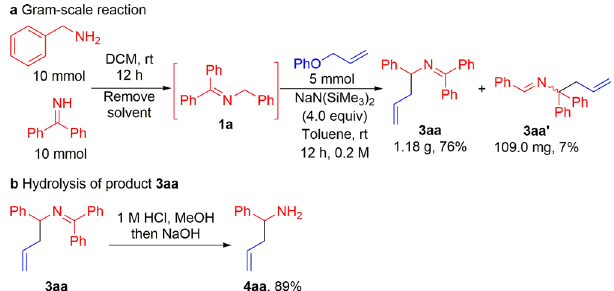
Fig. 5 Synthetic applications. a Gram-scale sequential one-pot imine generation/allylation process. b Allylated product hydrolysis to homoallylic the amine.